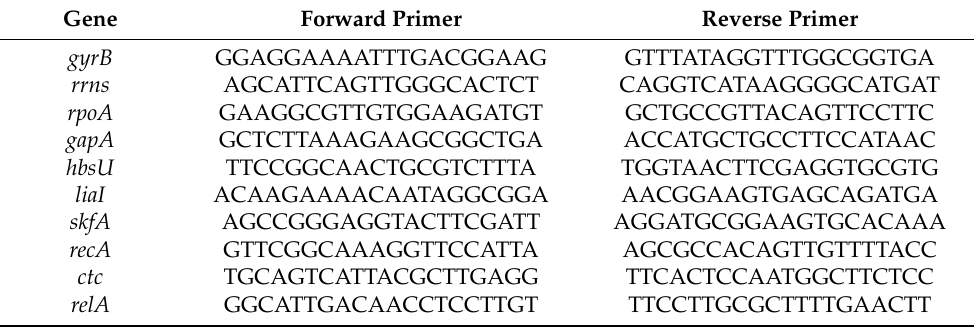
Table 1. Primers used for